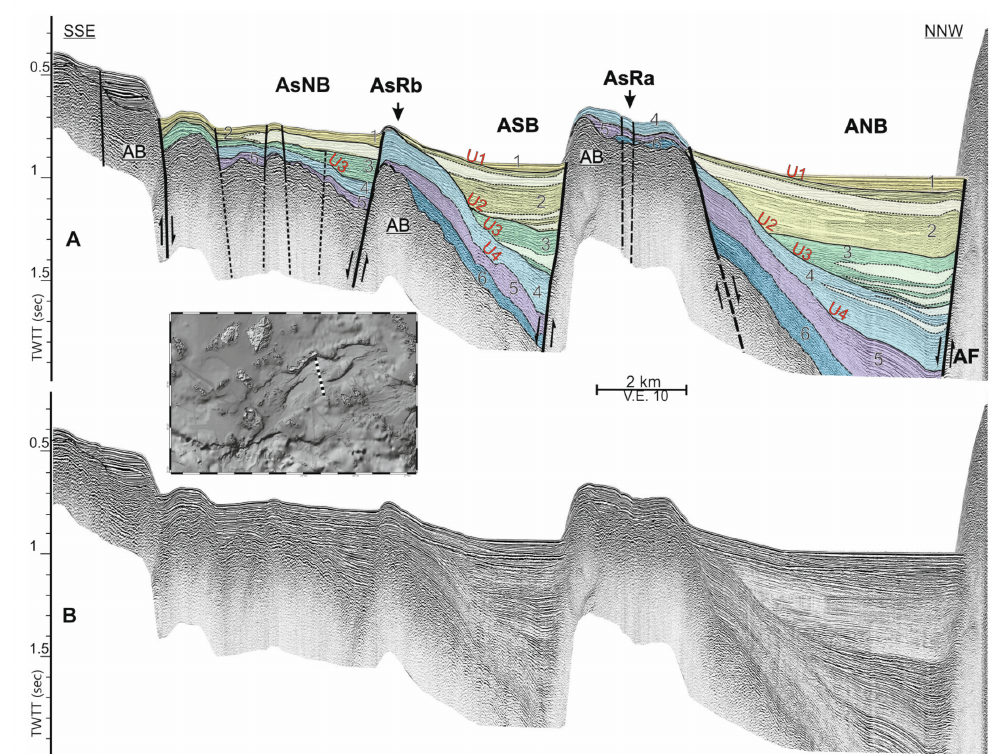
Figure 6. Airgun 40 ci seismic profile across the central part of Amorgos North Basin (ANB), the eastern part of Amorgos South Basin (ASB) and the western part of Astypalea North Basin (AsNB). Terminology and symbols as in Figure 4. AF: Amorgos Fault, AsRa: north splay of Astypalea Ridge and AsRb: south splay of Astypalea Ridge.